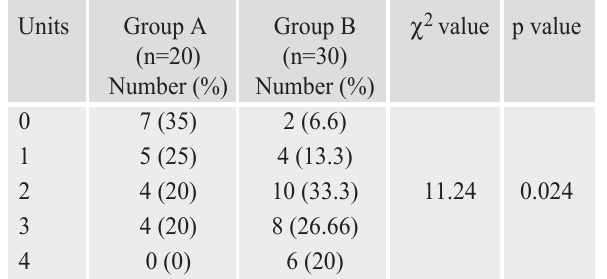
Table IV: Frequency of complications at or after